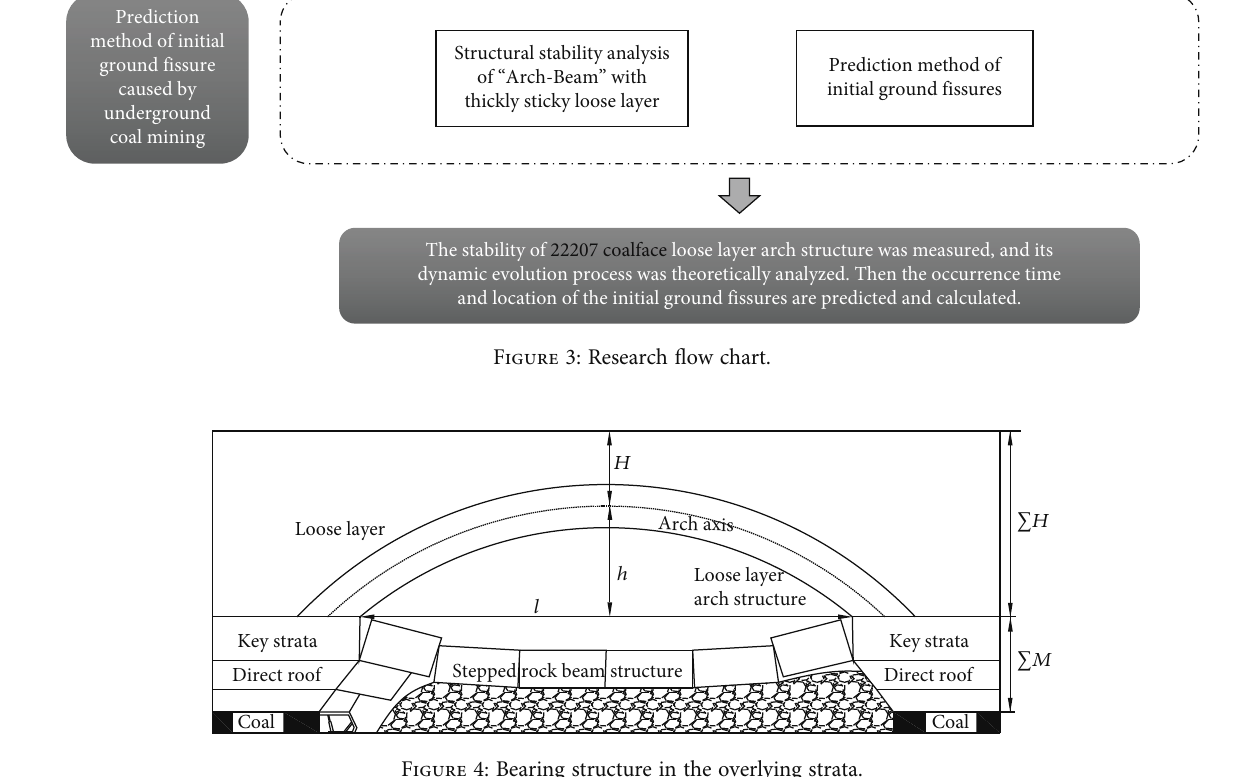
Figure 4: Bearing structure in the overlying